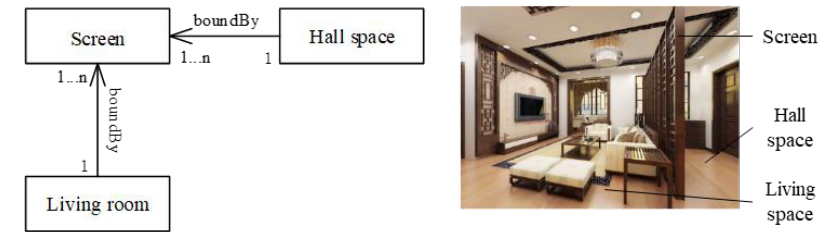
Figure 10. Boundary relationship